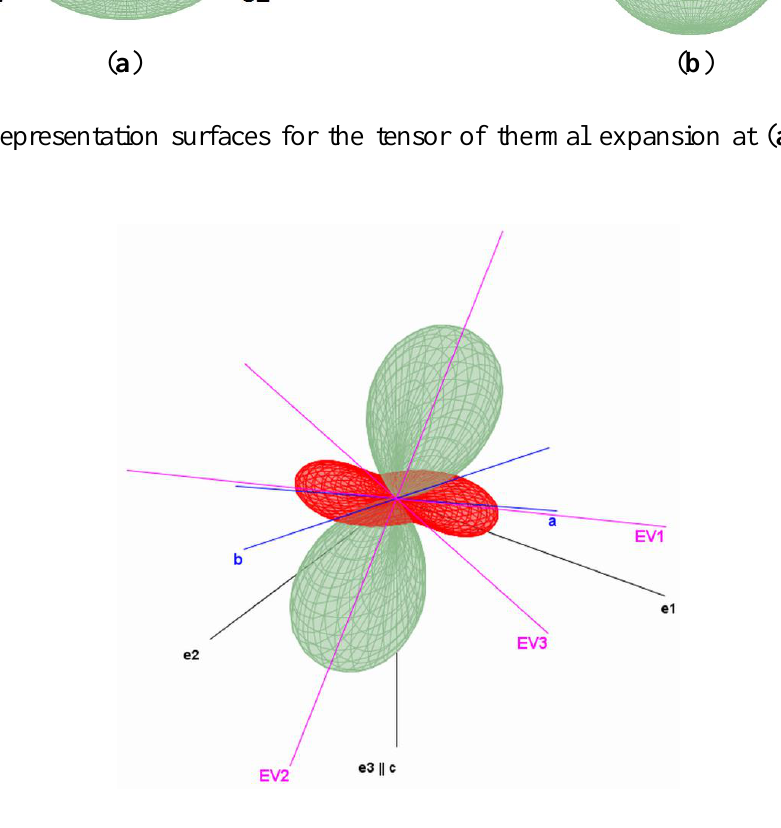
Figure 4. Representation surface of the thermal expansion tensor for α-CuMoO 4 at 70 K. Red parts of the surface indicate directions with negative values of thermal expansion. The crystallographic system {a , b , c} , the orthonormal system {e system of the eigenvectors {EV1, EV2, EV3} are indicated as